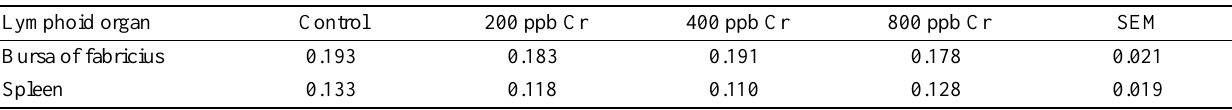
Table 4. Effect of chromium supplementation on lymphoid organ weight (percentage of live body weight) at 42 days of age Lymphoid organ